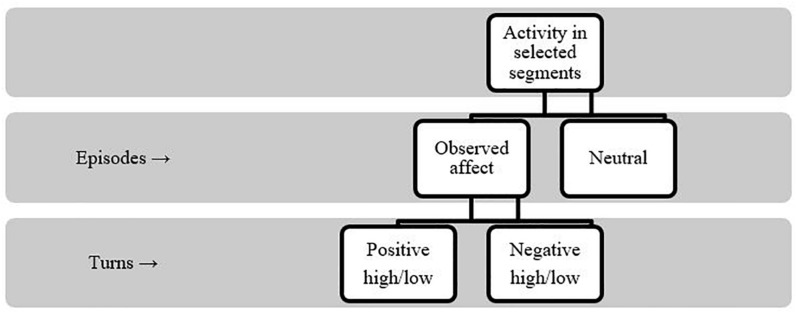
The coding protocol.